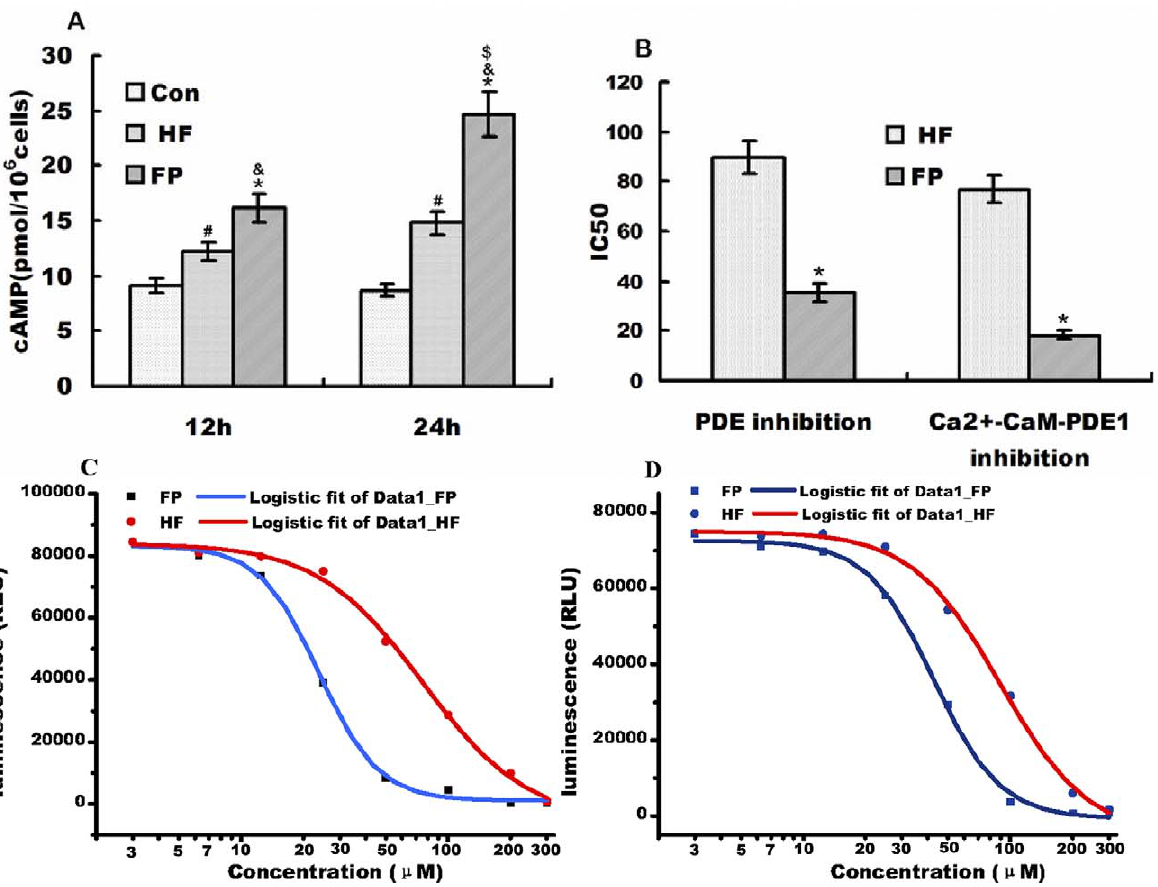
Figure 6. cAMP levels in Hela cells in each group and PDE inhibition activities invitro . A) cAMP concentrations in Hela cells in each group at 12 and 24 h. CON, control; HF, 20 m M HF group; FP, 20 m M FP group. B) Histogram representing inhibitory effects of FP and HP on PDE and CaM- activated PDE1 activity. C) Inhibitory effects of FP and HP on CaM-activated PDE1 activity. D) Inhibitory effects of FP and HP on PDE activity from bovine brain. Values are given as mean 6 SE; RLU (relative light units) on the y axes of panels C and D is positively related with CaM-activated PDE1 or PDE activities. The IC 50 was calculated by using a sigmoidal dose-response (variable slope) equation analysis. & p , 0.01 versus control group; * p , 0.001 versus HF group; # p , 0.01 versus control group; $ p , 0.01 versus 24 h FP